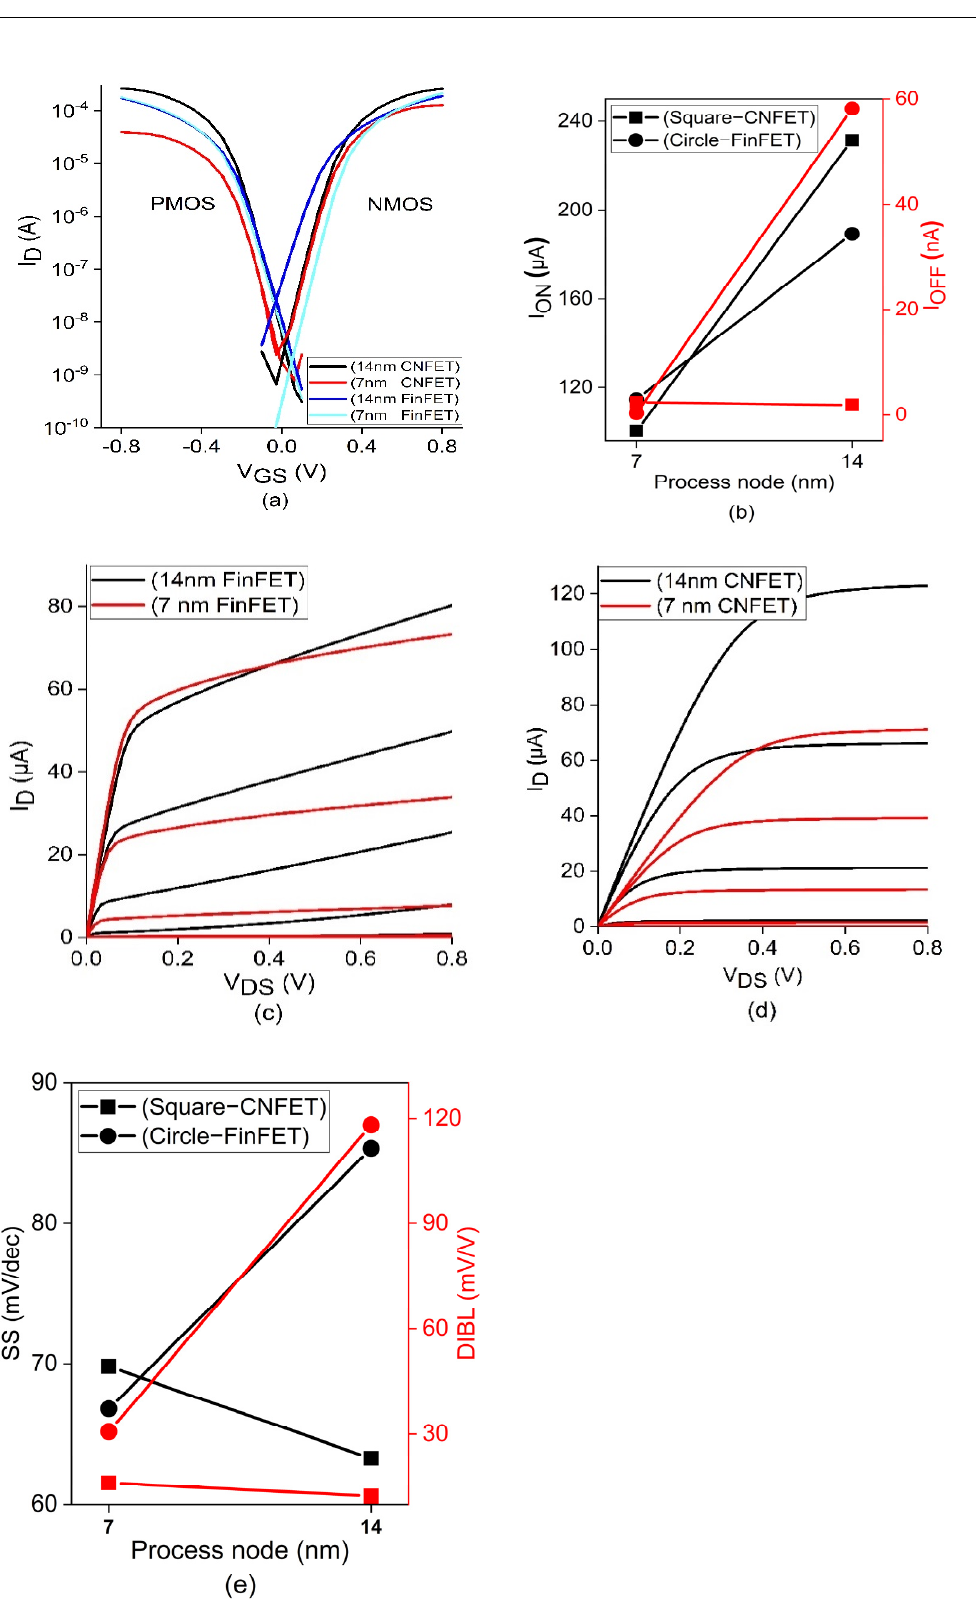
Figure 2. ( a ) Input characteristics of PMOS and NMOS of CNTFET and FinFET transistors. ( b ) ON current and OFF current ( c ) output characteristics of 14 and 7 nm FinFET ( d ) output characteristics of 14 and 7 nm CNTFET and ( e ) extraction of subthreshold slope and drain induced barrier lowering.